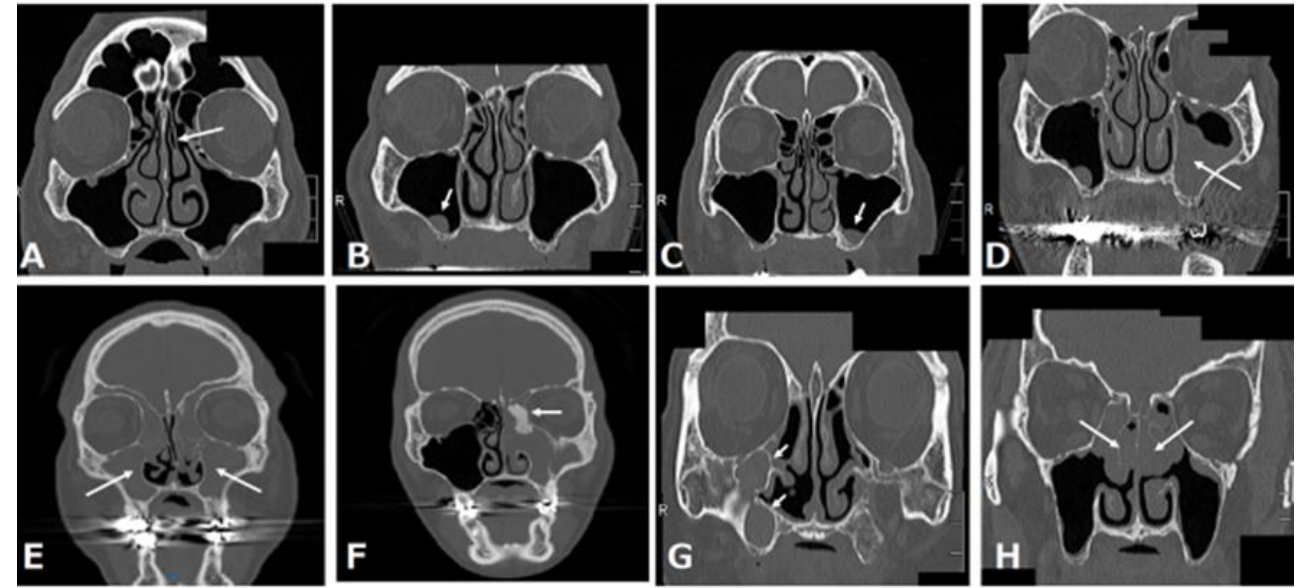
Figure 5. ( A ) Almost normal maxillary sinus and left concha bullosa of the middle turbinate (arrow); ( B ) retention cyst or solitary polyp in the right maxillary sinus (arrow); ( C ) mucosal thickening in the left maxillary sinus (arrow); ( D ) air-fluid level or fluid accumulation in the left maxillary sinus (most often indicating acute rhinosinusitis) (arrow); ( E ) total opacification of the maxillary sinus or other paranasal sinuses (most often indicating chronic rhinosinusitis) (arrow); ( F ) left chronic sinusitis with ethmoidal osteoma (arrow); ( G ) right two postoperative maxillary cysts (POMC) (arrow); ( H ) eosinophilic chronic rhinosinusitis (arrow).